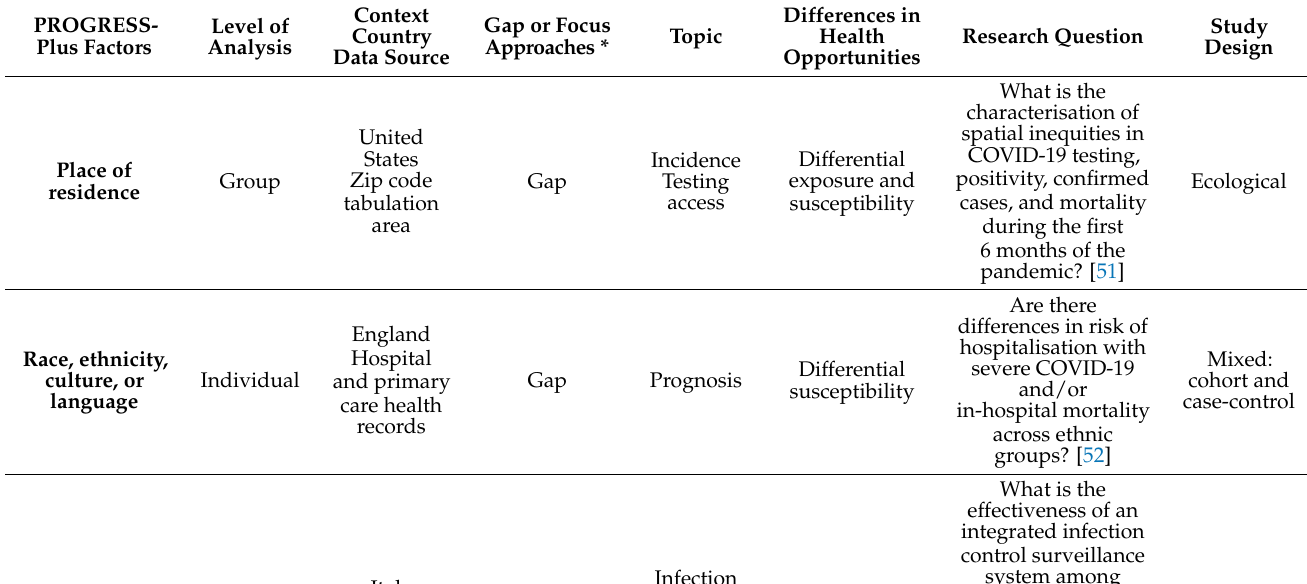
Table 1. Examples of COVID-19 observational